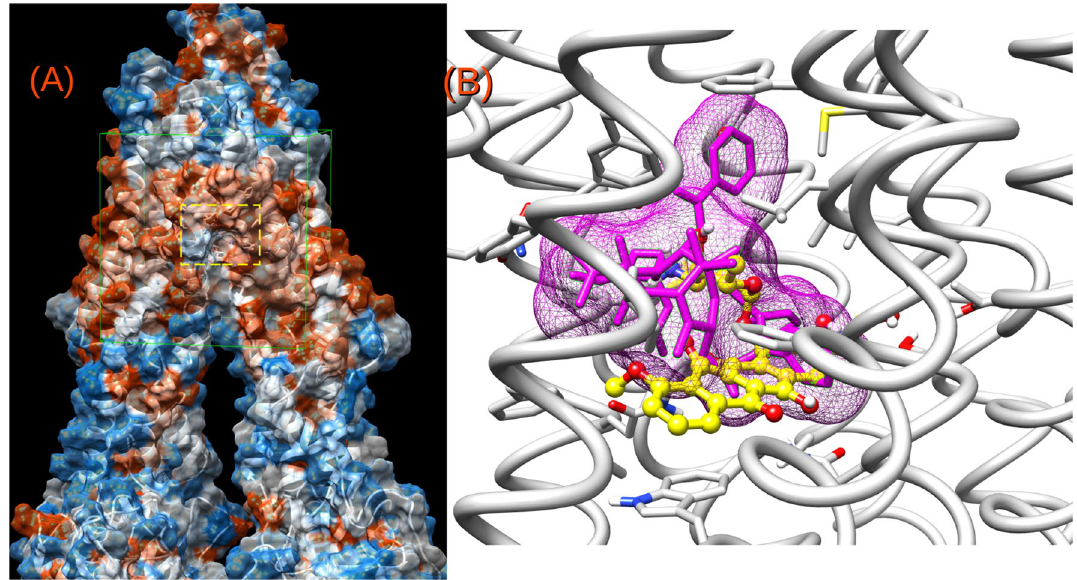
Figure 5. ( A ) Distant view of the P-gp surrounded by a molecular surface (probe 1.4 Å) colored according to its hydrophobicity (orange → most hydrophobic). The green cube indicates the docking region; the dotted yellow rectangle is zoomed in ( B ). ( B ) Superimposition of doxorubicin (yellow) and the co-crystallized chemotherapeutic drug, Taxol